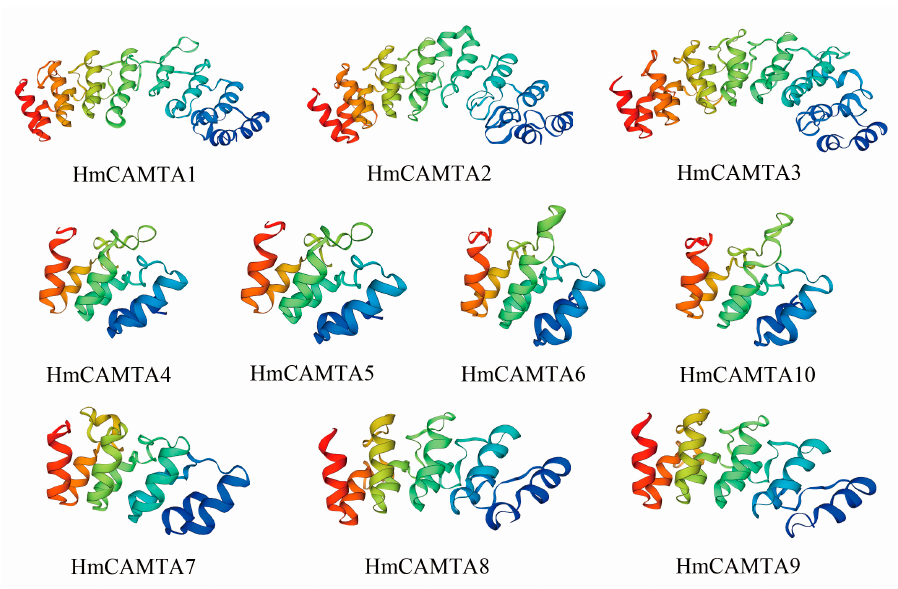
Figure 1. Tertiary structure prediction of HmCAMTA protein.